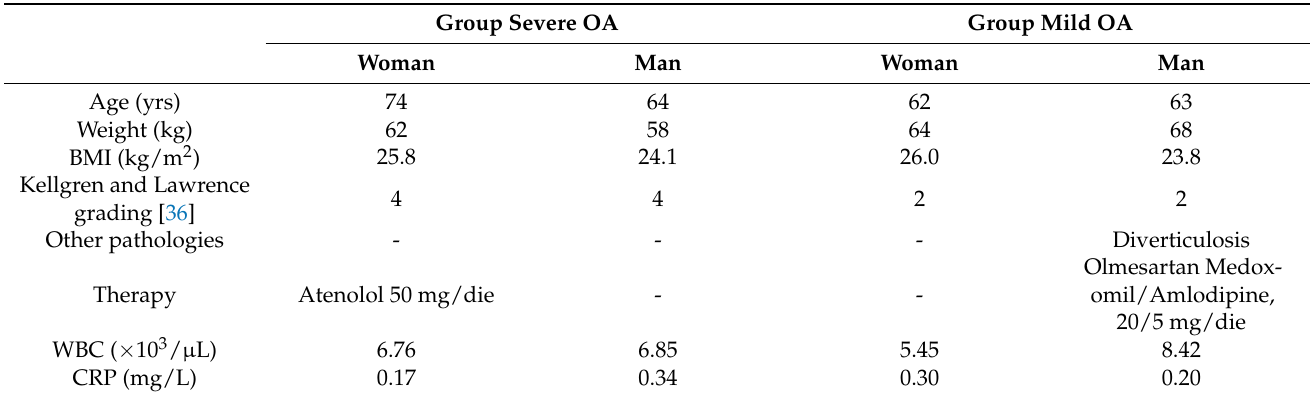
Table 1. Demographic and clinical data of selected